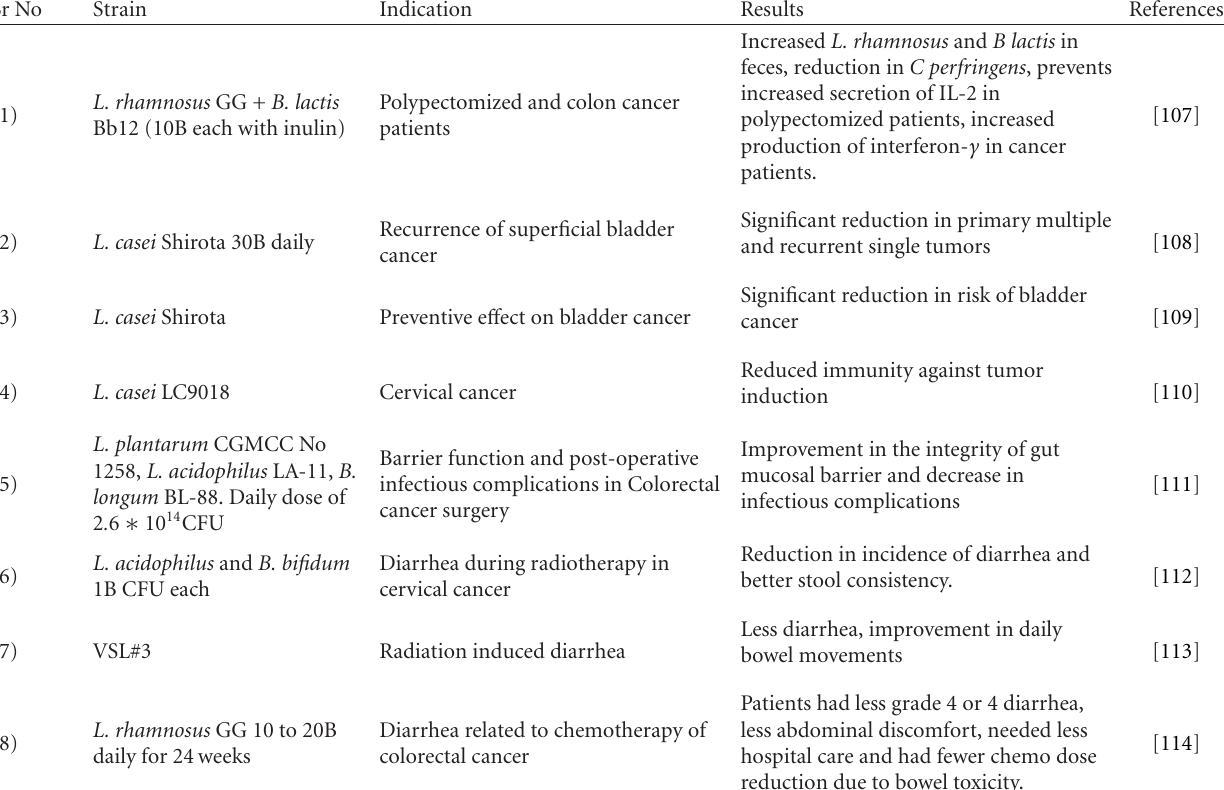
Table 1: Various probiotic strains and their applications in di ff erent types of cancer and side e ff ects associated with